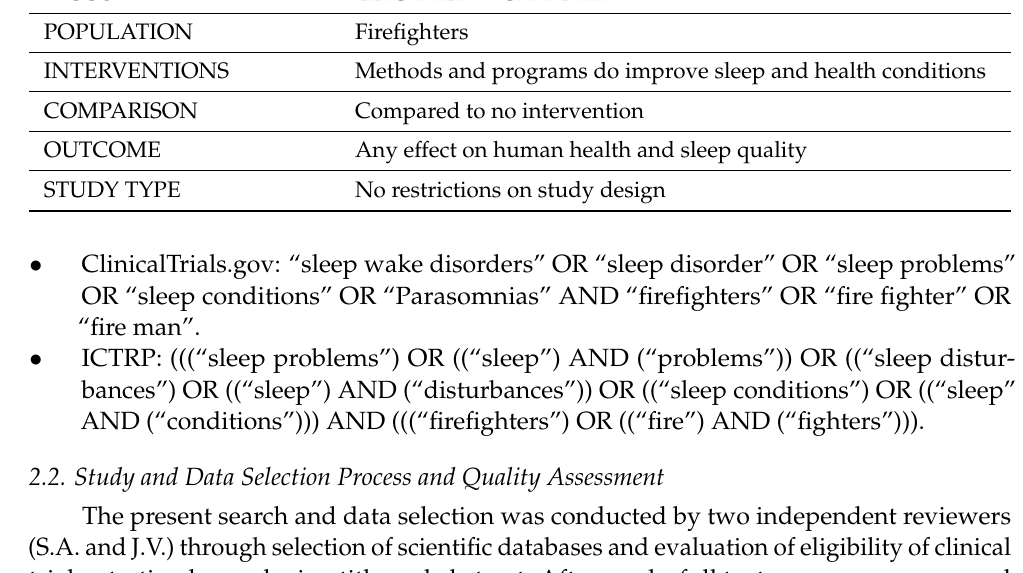
Table 1. Population, intervention, comparison, outcome, study design (PICOS) criteria for eligibility. PICOS